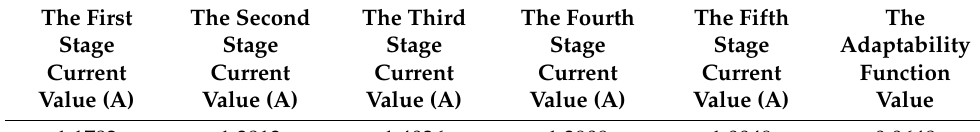
Table 3. Simulation results of five-stage constant current charging strategy.